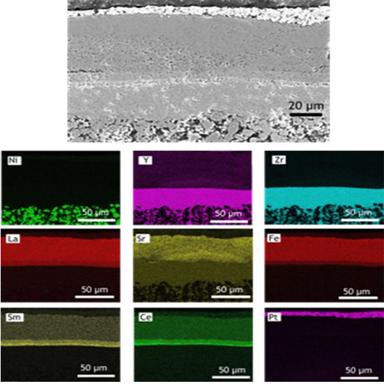
SEM micrograph and EDS compositional analysis of the full fabricated single-cell.